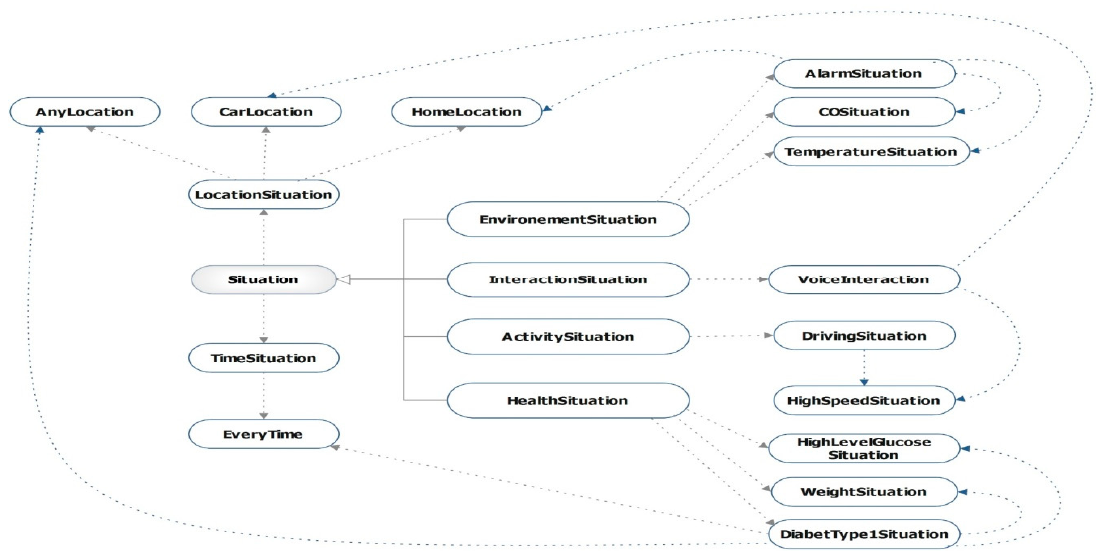
Figure 13. Situation sub ‐ ontology.